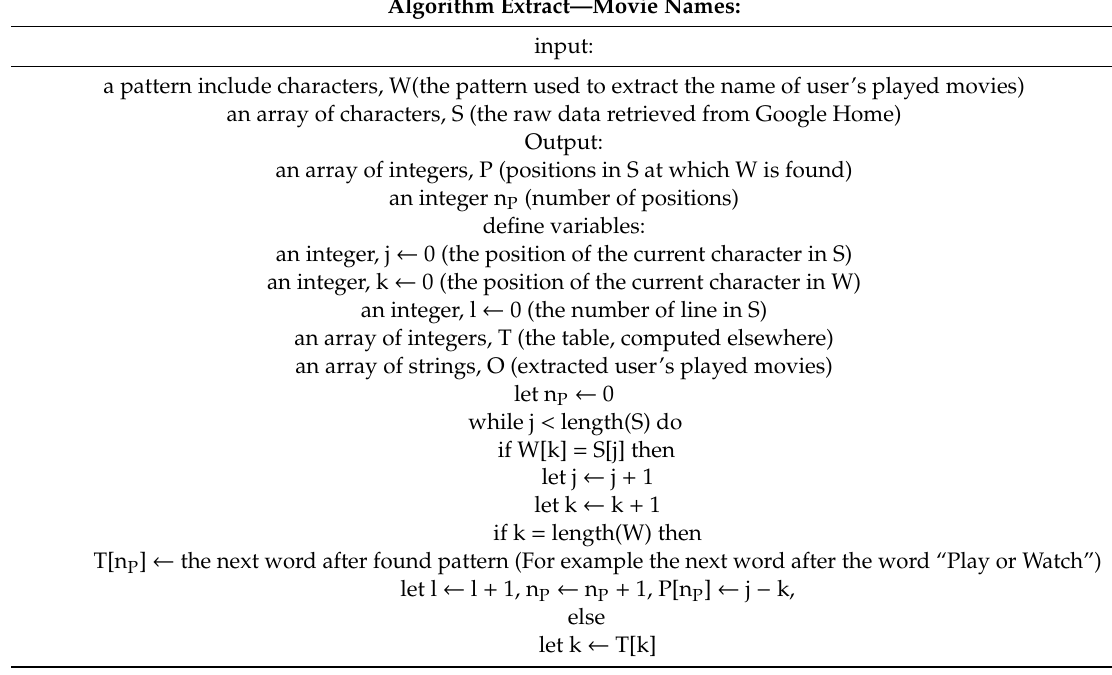
Table 2. Knuth–Morris–Pratt Algorithm to extract users’ played movies from Google Home’s textual